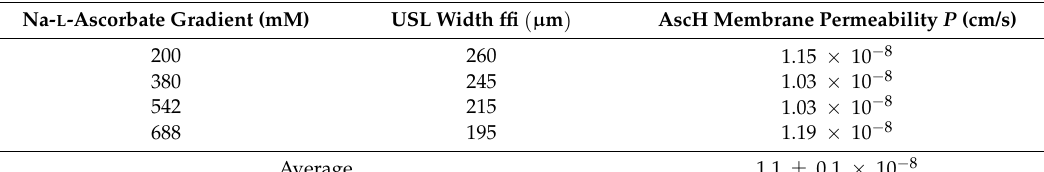
Table 2. Unstirred layer width and AscH acid permeability P for various gradients of Na-Asc. Na- L -Ascorbate Gradient (mM)